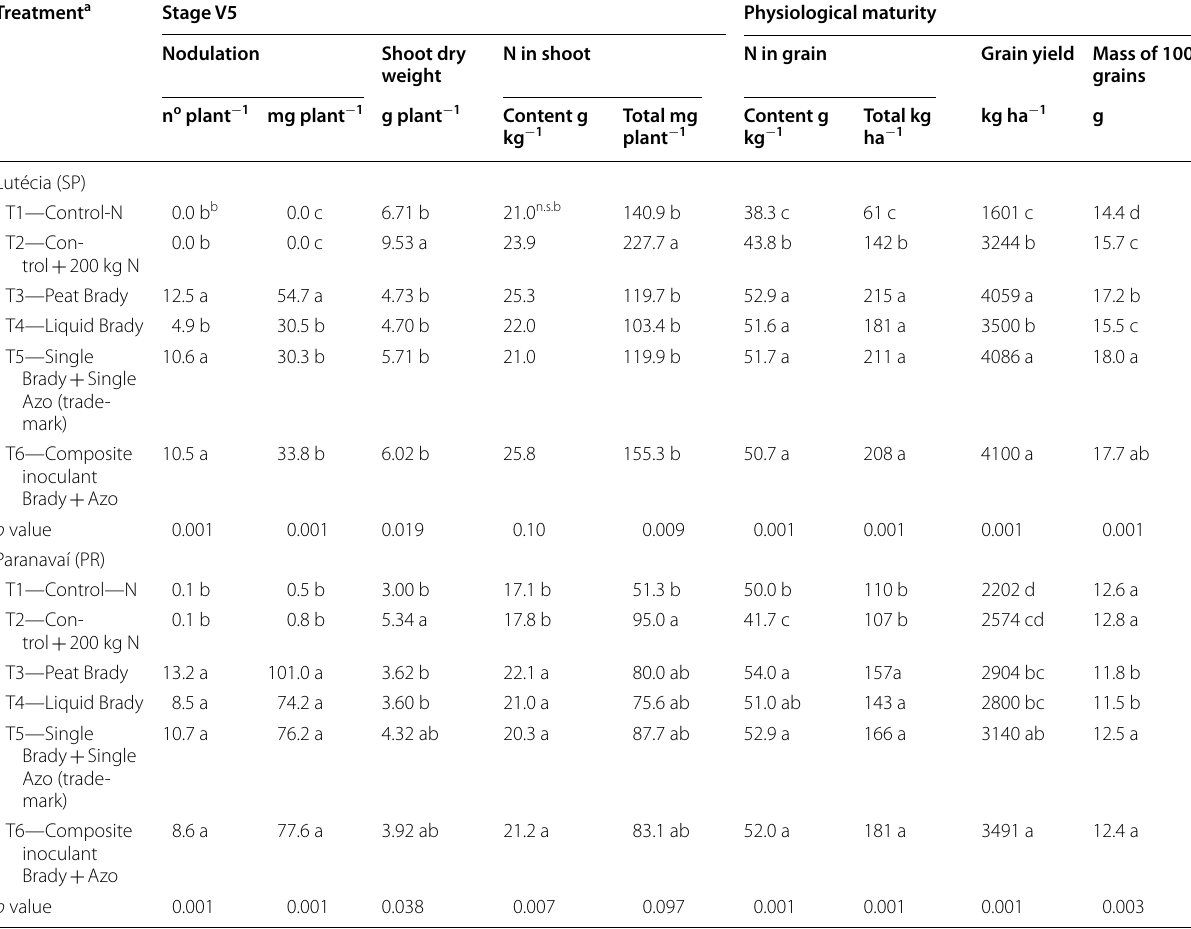
Table 5 Parameters evaluated in soybean cultivar BRS 1010IPRO with different treatments of inoculation with Bradyrhizobium and co-inoculation with Bradyrhizobium and Azospirillum in field trials performed in first-year cropping areas, without naturalized population of compatible soybean bradyrhizobia, in Lutécia-SP e Paranavaí-PR,